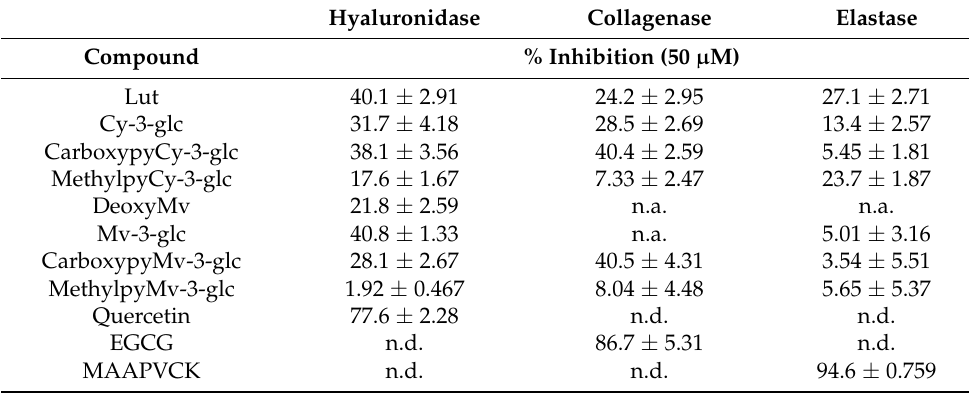
Table 4. Inhibitory activities of anthocyanins and related structures against hyaluronidase, col- lagenase and elastase. Quercetin at 50 µ M, epigallocatechin gallate (EGCG) at 50 µ M and N- (Methoxysuccinyl)-Ala-Ala-Pro-Val-chloromethyl ketone (MAAPVCK) at 10 µ M were used as posi- tive controls for hyaluronidase, collagenase and elastase, respectively. Results are presented as the mean ± standard error deviation (SEM) of at least 3 independent